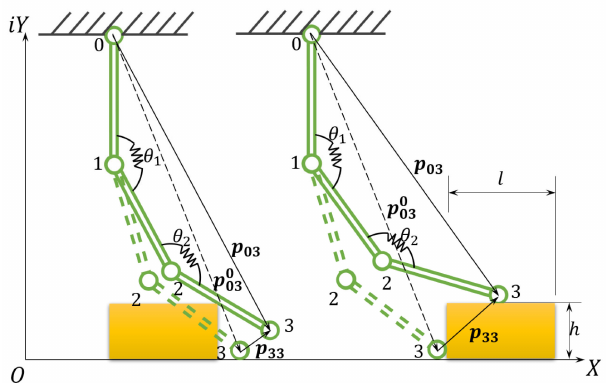
Figure 4. Schematic diagram of debris block traversing. Note: ( Left ) cup starts to make contact, ( Right ) cup makes full contact with the block. The cup is travelling from right to left, w.r.t. the set